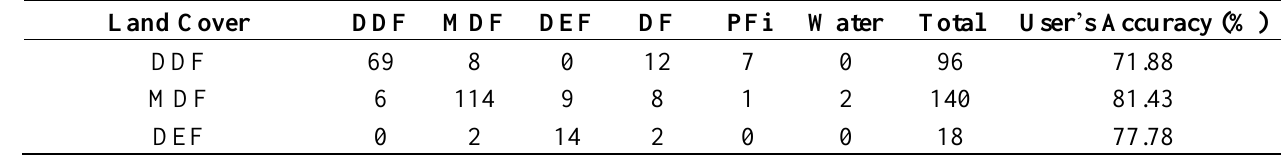
Table 9. The accuracy assessment of the hybrid land-cover classification technique. Land